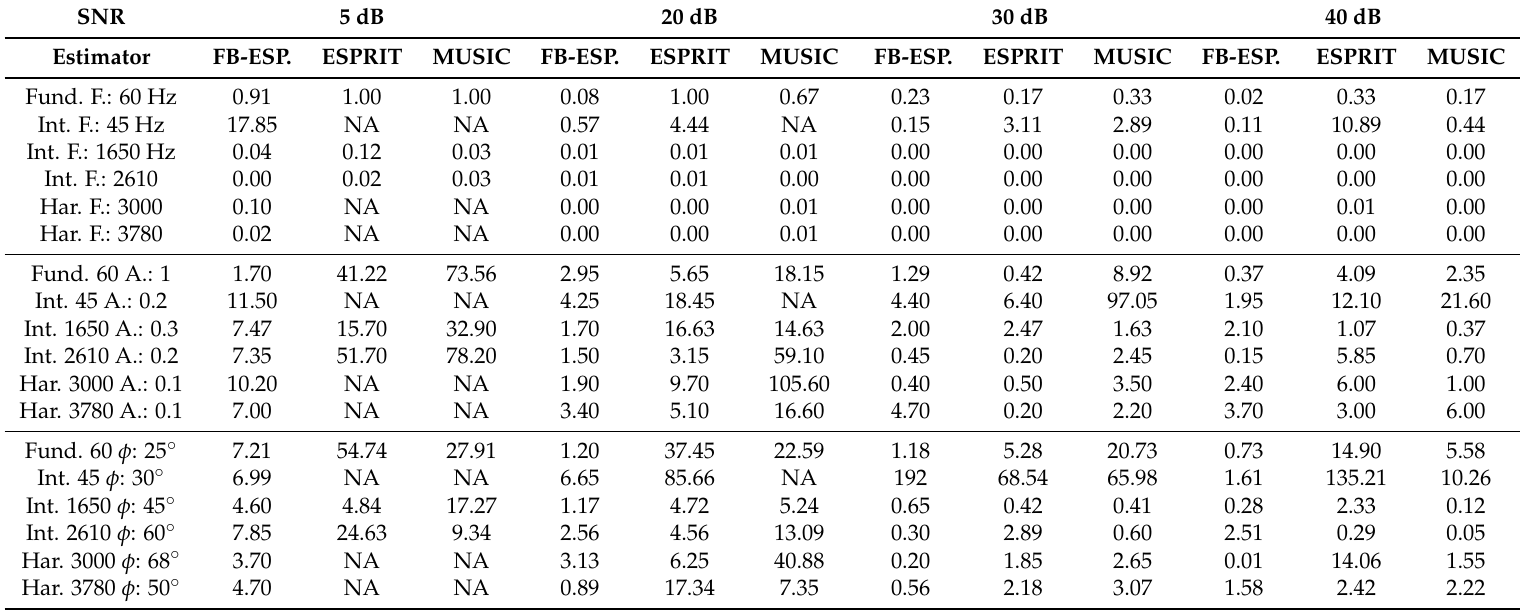
Table 8. Mean percent error (%) of signal s 2 ( t ) parameters estimated in 1000 runs by FB-ESPRIT, ESPRIT, and MUSIC at different levels of SNR (5, 20, 30, 40 dB) under contamination by pink